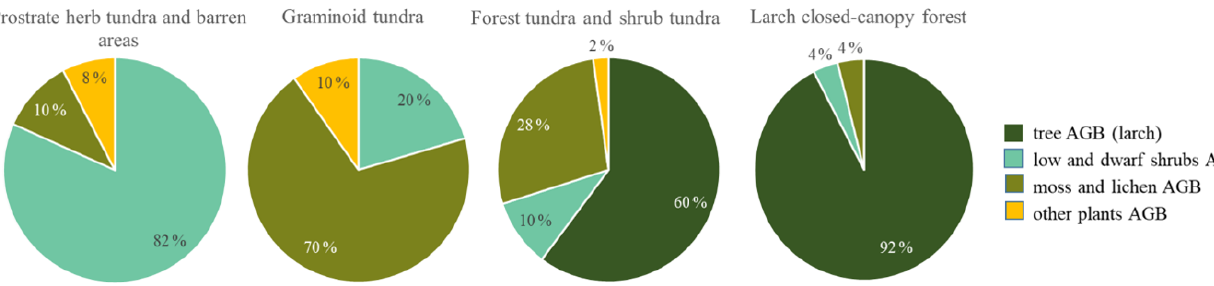
Figure 5. Plot-scale average (median) partial AGB in the four vegetation classes. Tall shrubs ( Alnus fruticosa, Pinus pumila ) were rare and made up less than 1% of the average plot AGB and are not included